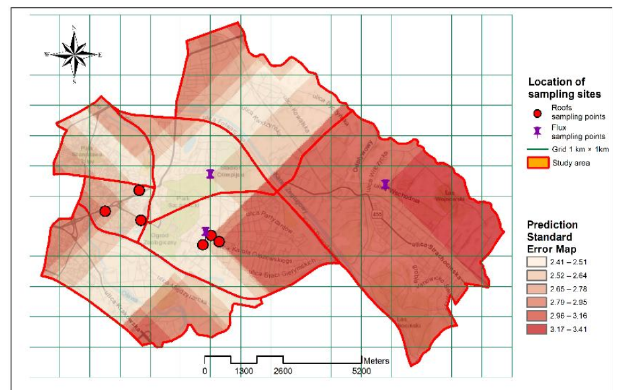
Figure 15. Ordinary kriging prediction standard error map with the grid (1 km × 1 km) within a particular study